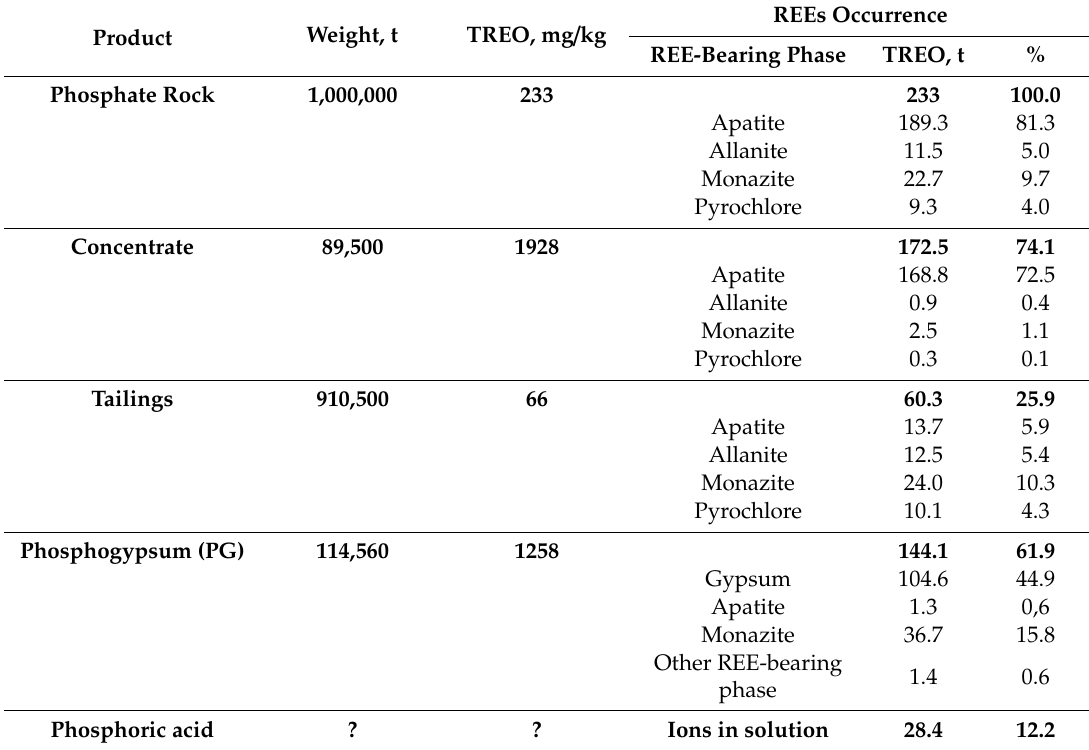
Table 12. The Occurrences of REO in the Processing